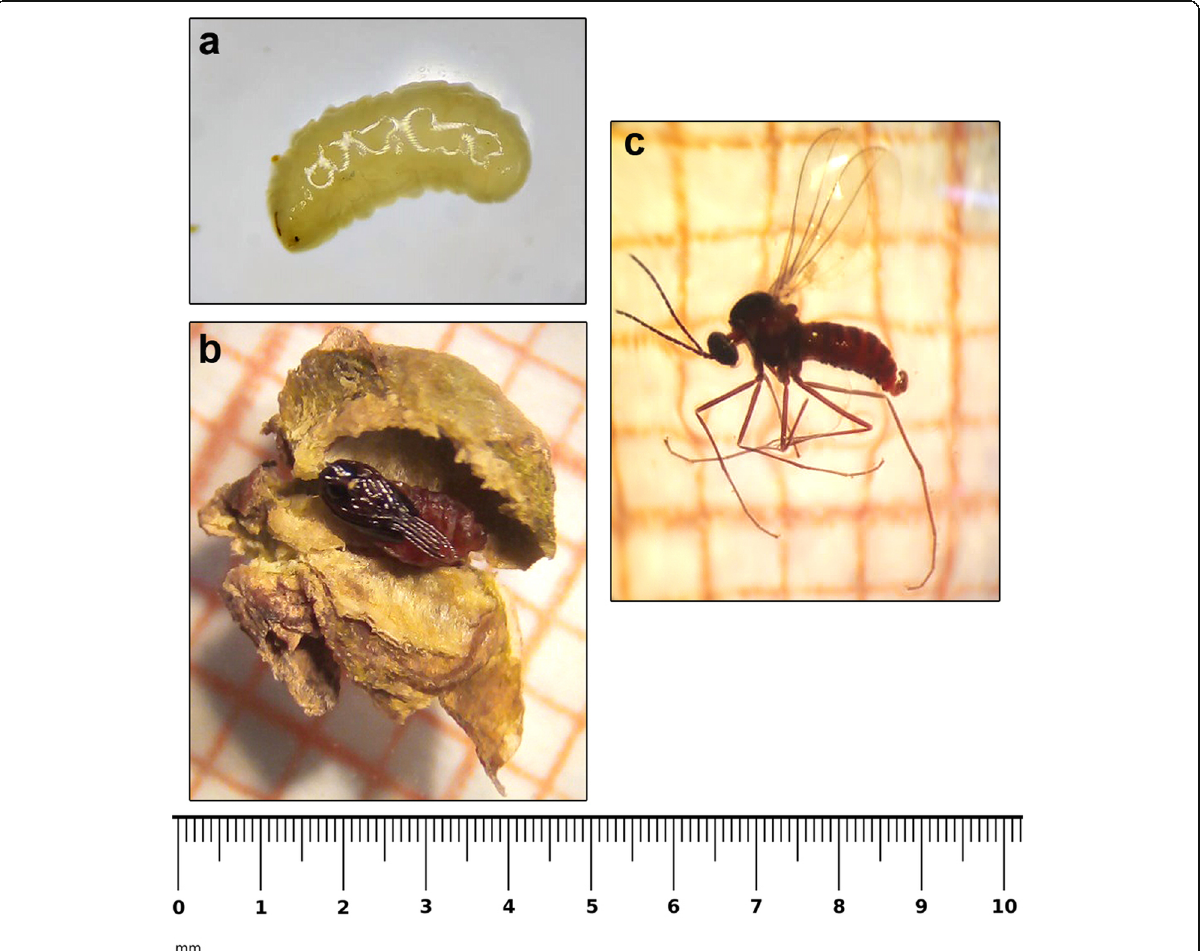
Fig. 1 The gall midge Schizomyia buboniae Frauenfeld, 1859 (Diptera: Cecidomyiidae). a Ethanol-preserved larvae (3 mm), b pupa (3 mm), and c adult (2.5 mm)